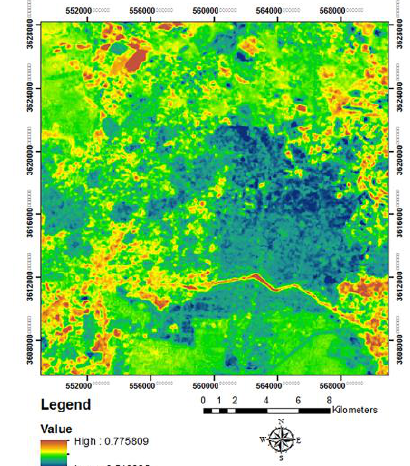
Figure 6. Pixel-based spatiotemporal dynamics of land surface temperature in Isfahan Metropolitan Area during 1998-2014 time